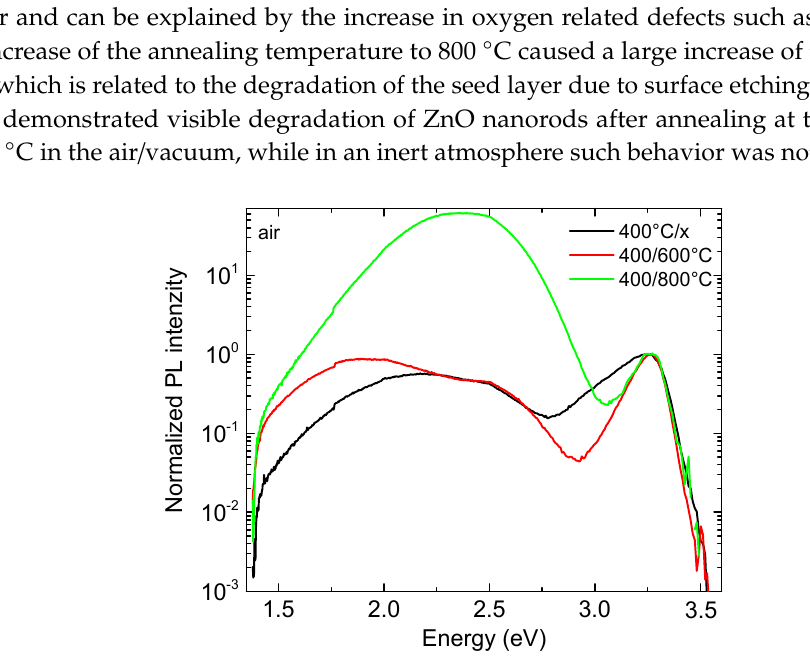
Figure 7. Room temperature photoluminescence spectra of the seed layer preheated and annealed in the air at different temperatures. Black line 400 °C; red line 400 °C/600 °C; green line 400 °C/800 °C.